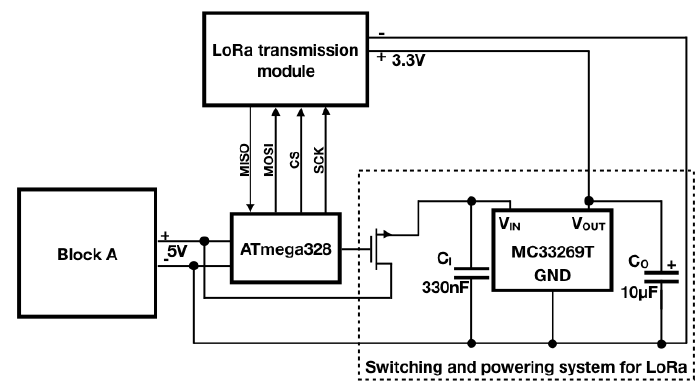
Figure 5. Diagram of the Switching and powering system for LoRa